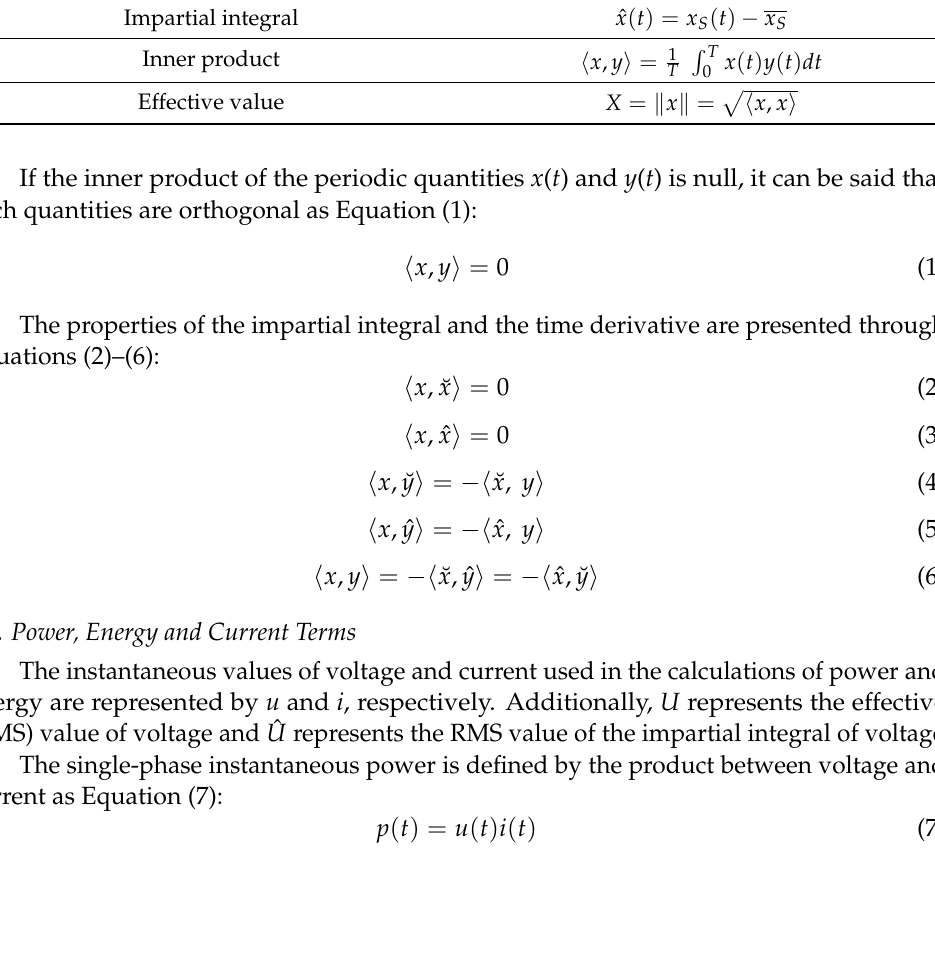
(cid:82) T x ( t ) dt T 0 dt x ( τ ) d τ 0 (cid:82) T x ( t ) y ( t ) dt T 0